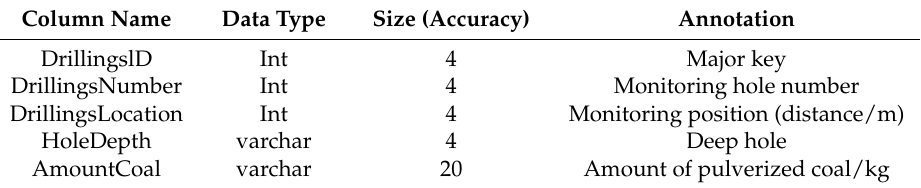
Table 7. Drillings dimension table properties.